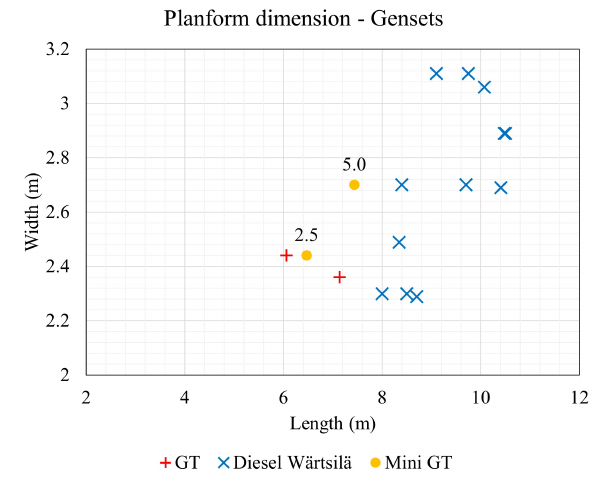
Figure 3. Calculated size for two Mini Gas Turbines—SC, 2.5 and 5.0 MW el —vs. marine engine sizes available on the market. Dimensions refer to complete generating